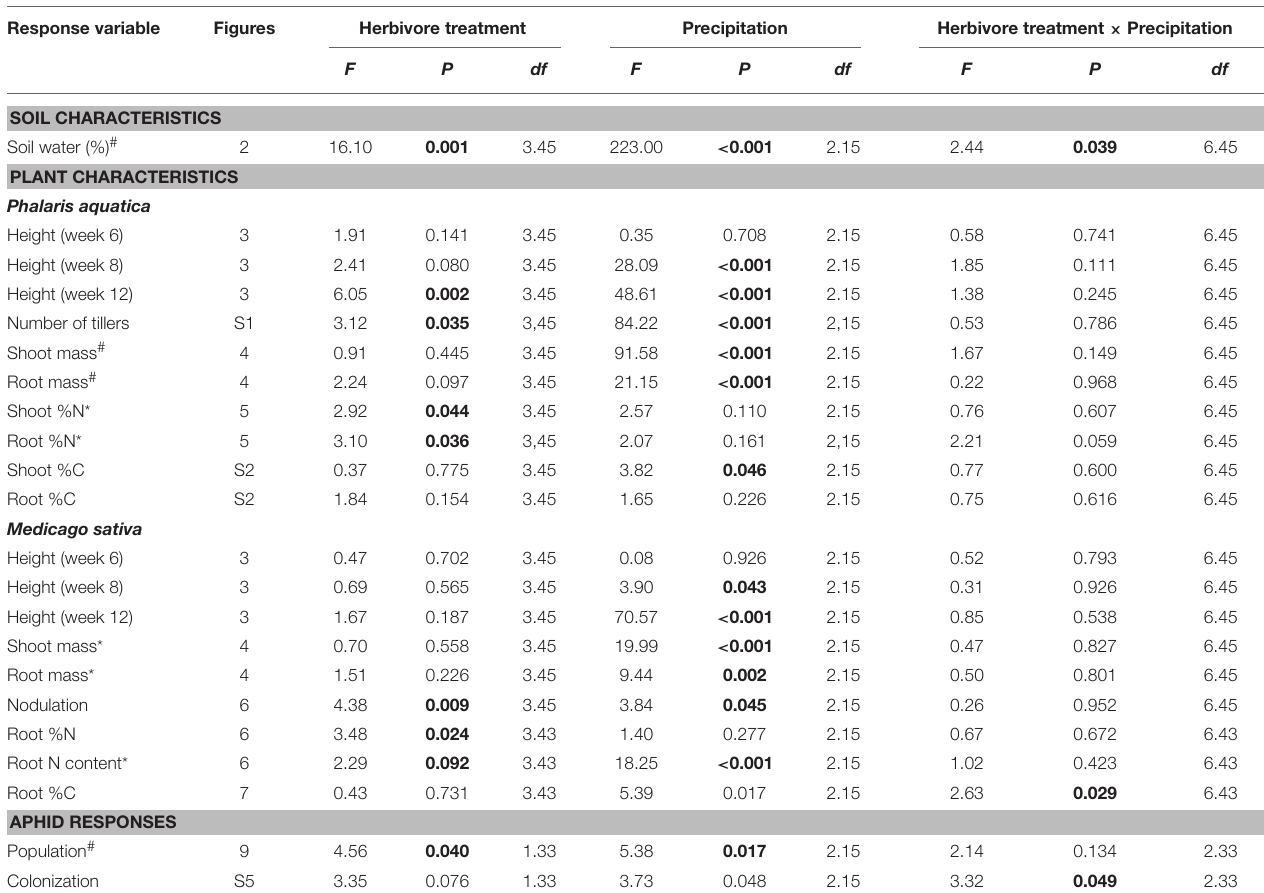
TABLE 1 | Soil, plant, and aphid responses to precipitation and herbivore treatments from linear mixed models. Response